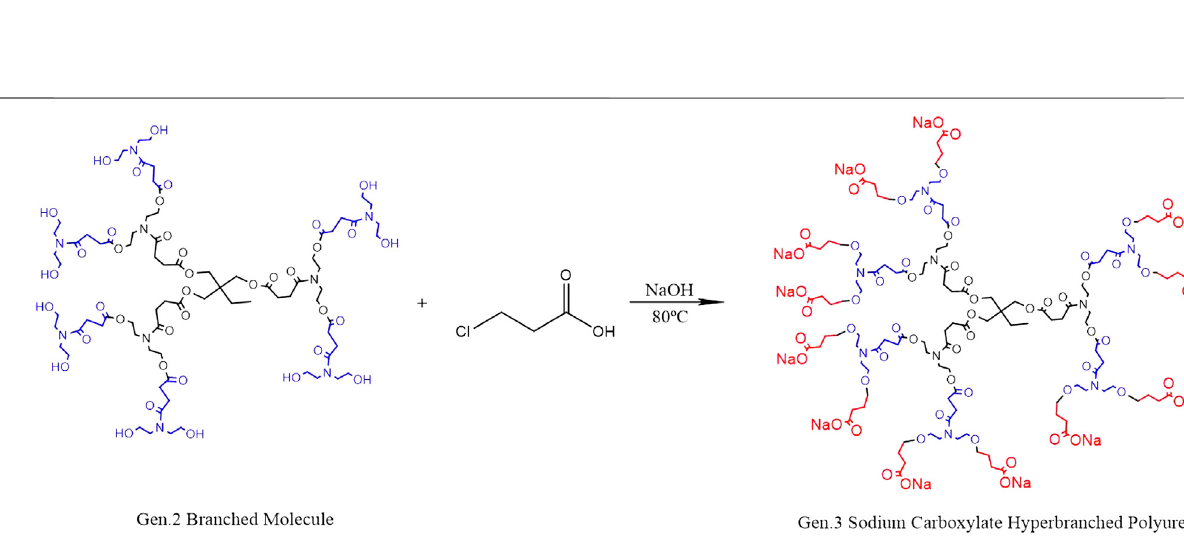
Frontiers in Chemistry |